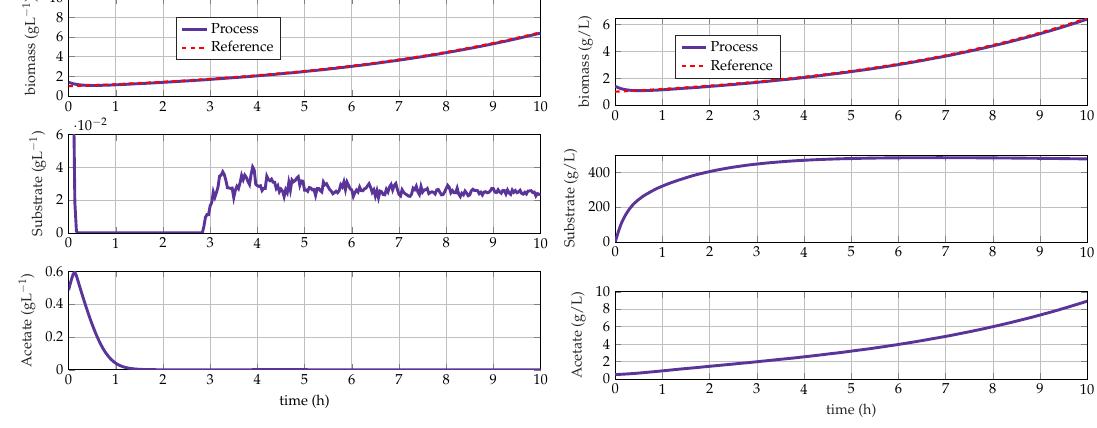
Figure 5. State variable evolutions with the full-order model ( Right ) and the reduced model ( Left ).